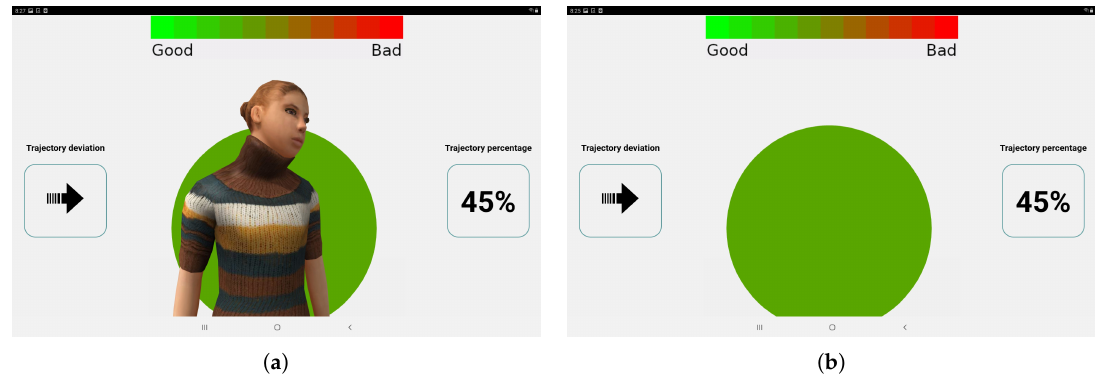
Figure 3. User interfaces for User Study 2 . ( a ) The dashboard with the avatar (torso) ( b ) The dashboard without the avatar.